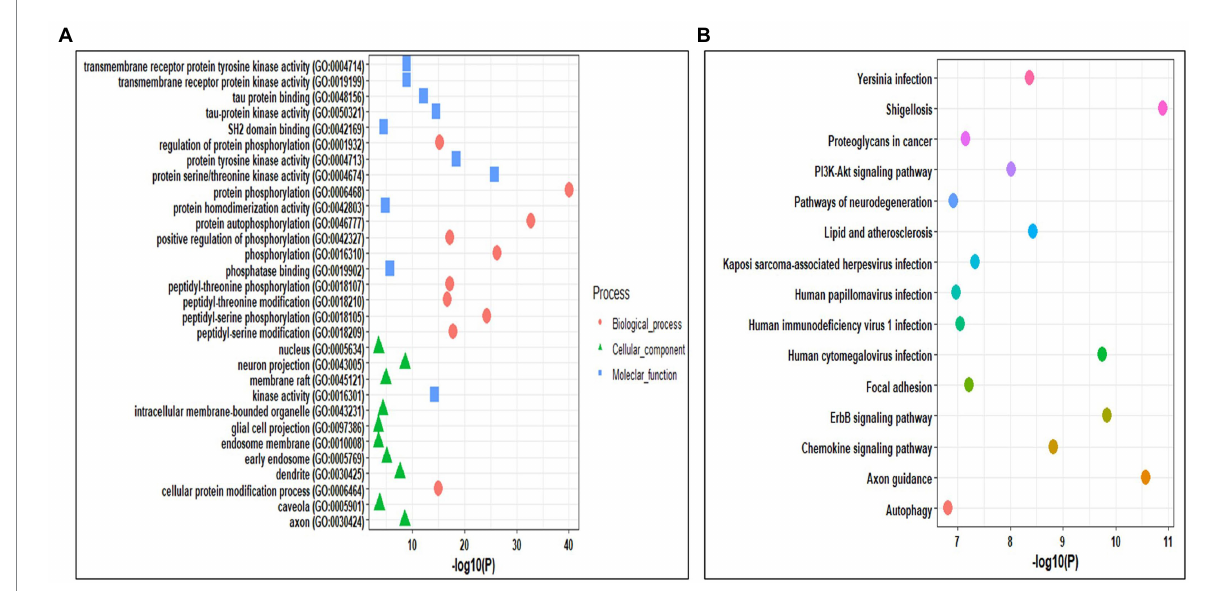
FIGURE 3 (A) Gene Ontology enrichment analysis of the identified kinases. (B) KEGG pathway enrichment analysis of the identified